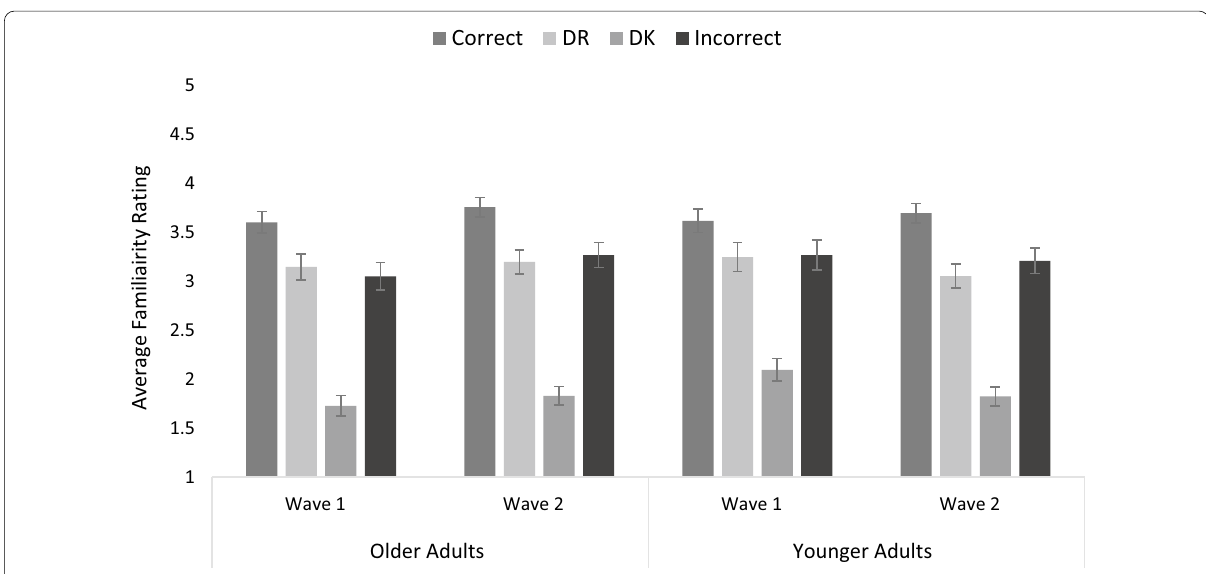
Fig. 1 Average familiarity as a function of age, wave, and response type (error bars represent standard error of the